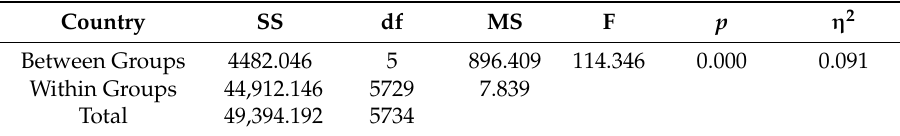
Table A1. Level of religiosity among countries.